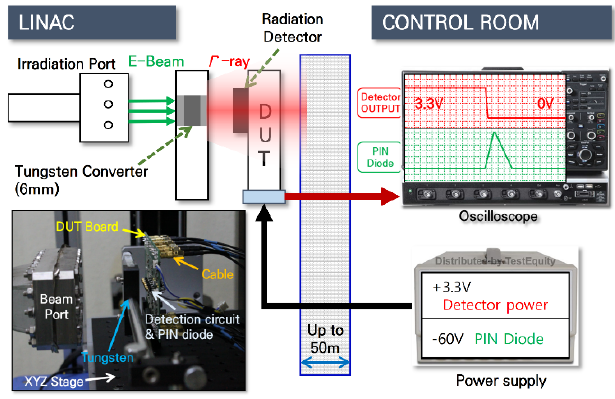
Figure 14. Transient effect test evaluation setup of the pulsed radiation detector.